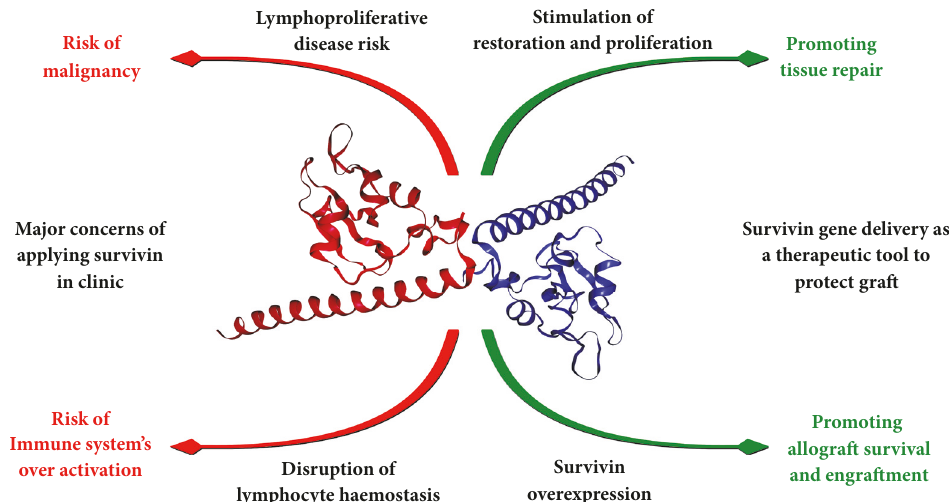
Figure 2: An overvie w of the role of survivin in transplantation. The effects of survivin on the transplantation are categorized in two general groups of the advantages and